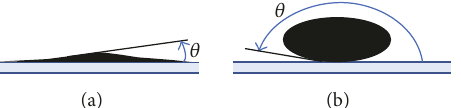
Figure 3: The principle of water repellency: (a) untreated concrete, contact angle 𝜃 less than 90 ∘ ; (b) water repellent treated, contact angle 𝜃 greater than 90 ∘ .